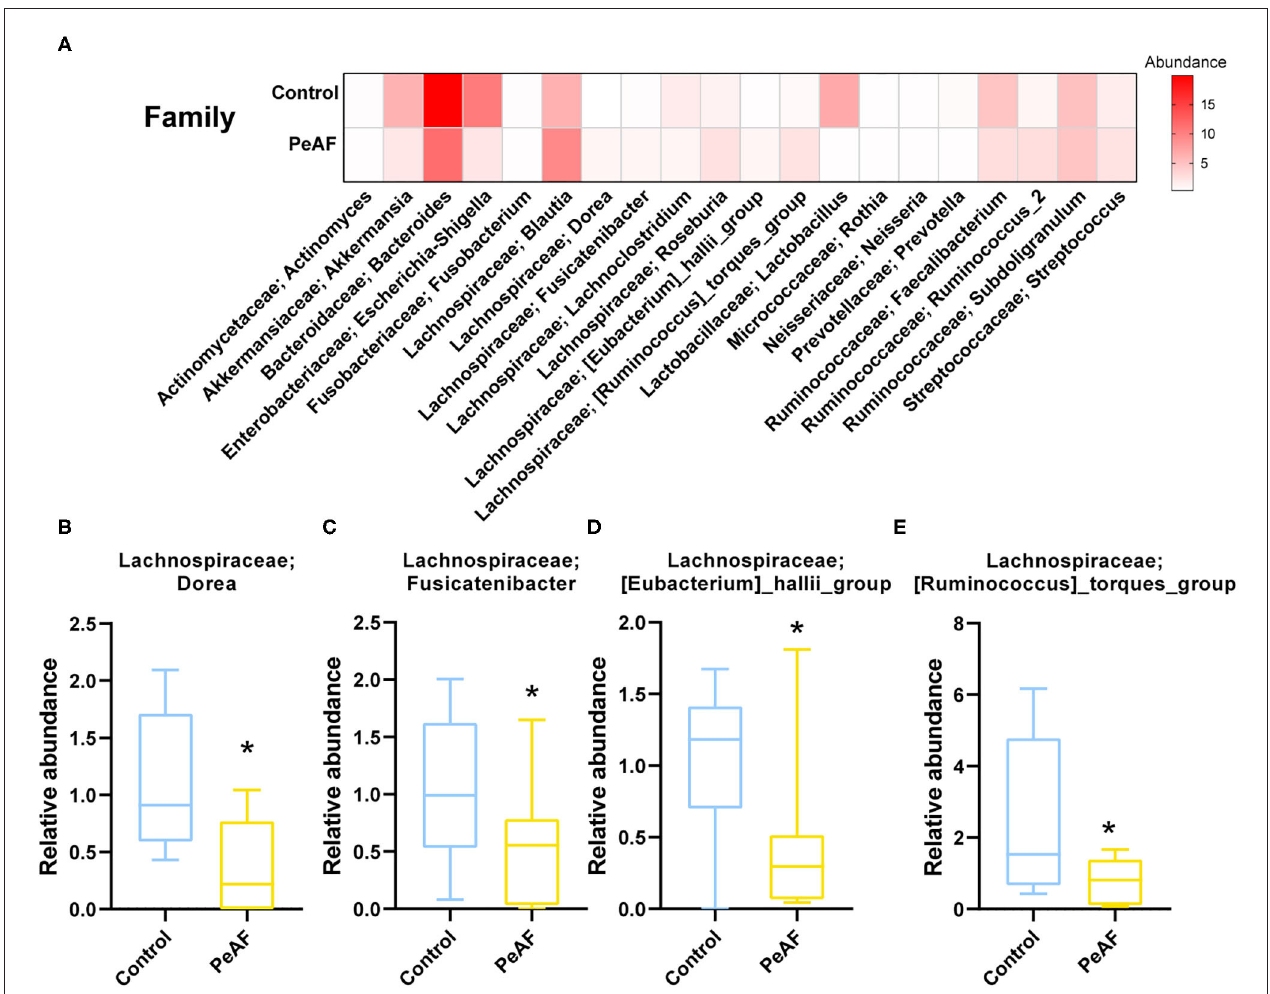
FIGURE 4 | Variations in the abundances in the intestinal flora at the family level. (A) Abundance heat map of the top 20 families; the darker the color is, the higher the abundance level. (B) The relative abundance of Lachnospiraceae; Dorea . (C) The relative abundance of Lachnospiraceae; Fusicatenibacter . (D) The relative abundance of Lachnospiraceae; [Eubacterium]_hallii_group . (E) The relative abundance of Lachnospiraceae; [Ruminococcus]_torques_group . *Compared to the control group, p <